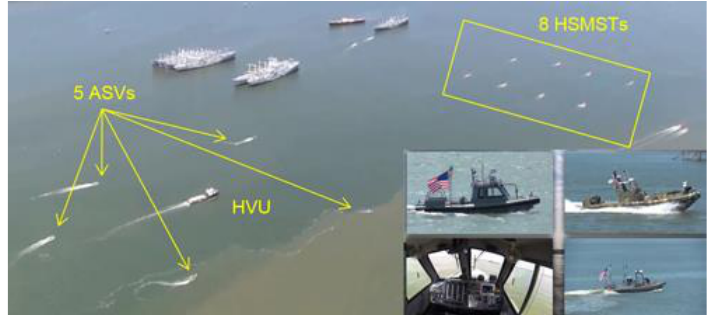
Figure 1. Office of Naval Research swarm demonstration in the James River in Virginia using NASA’s